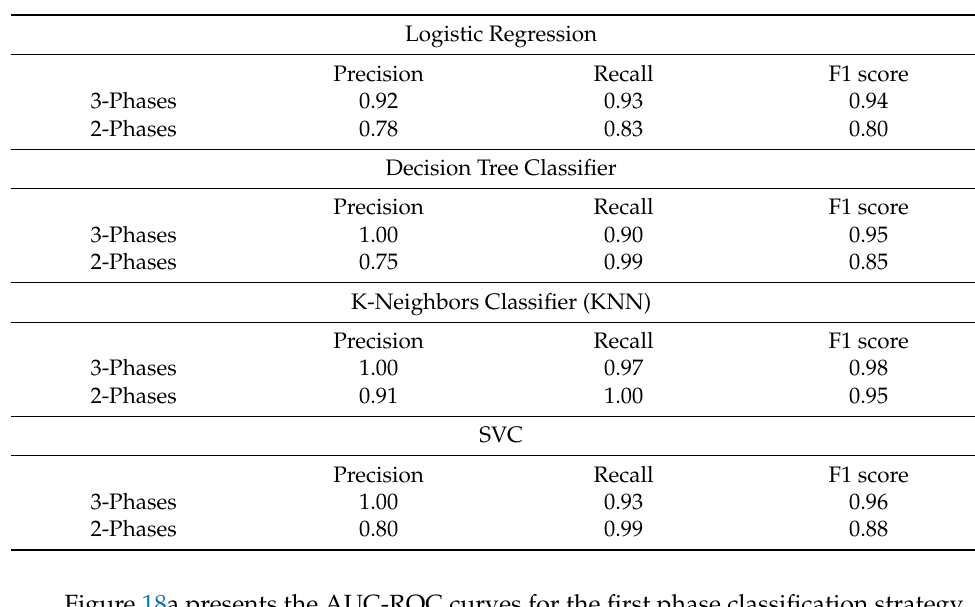
Table 6. Classification Phase Report—Strategy 1.